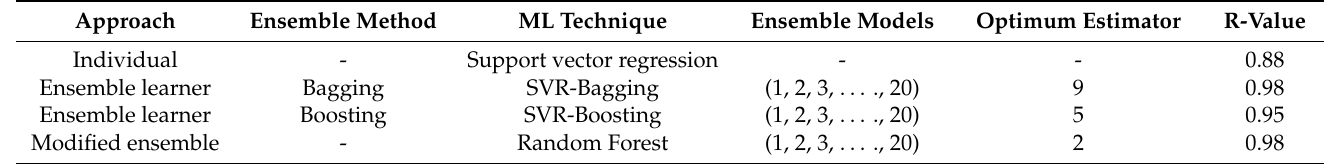
Table 4. Analysis method for optimum